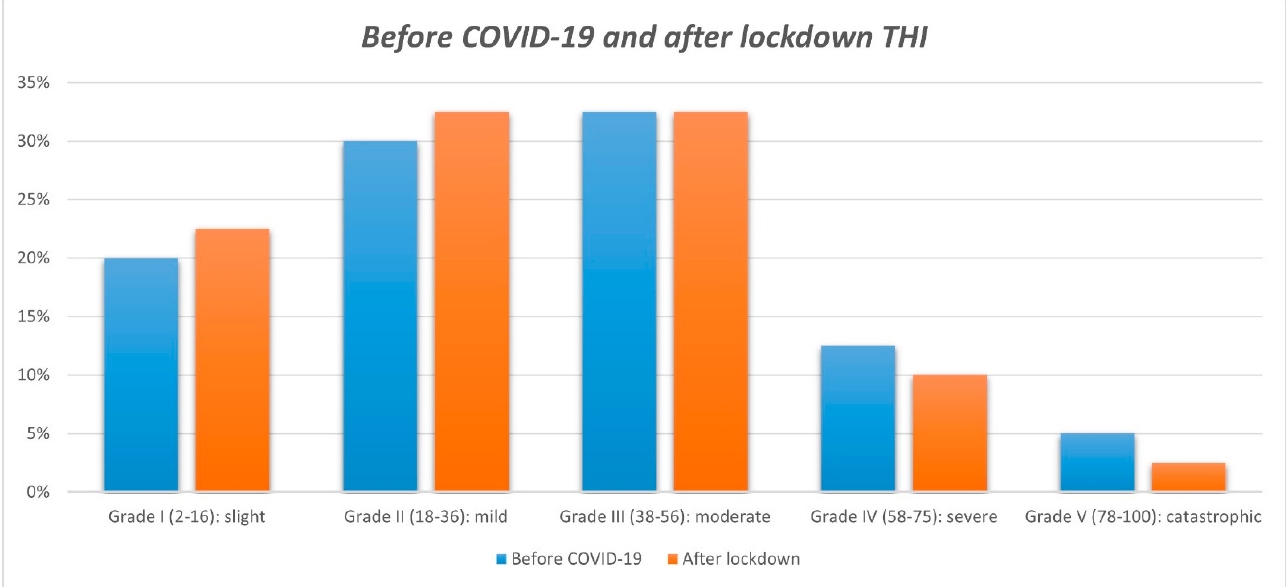
Figure 1. THI grades before COVID-19 and after